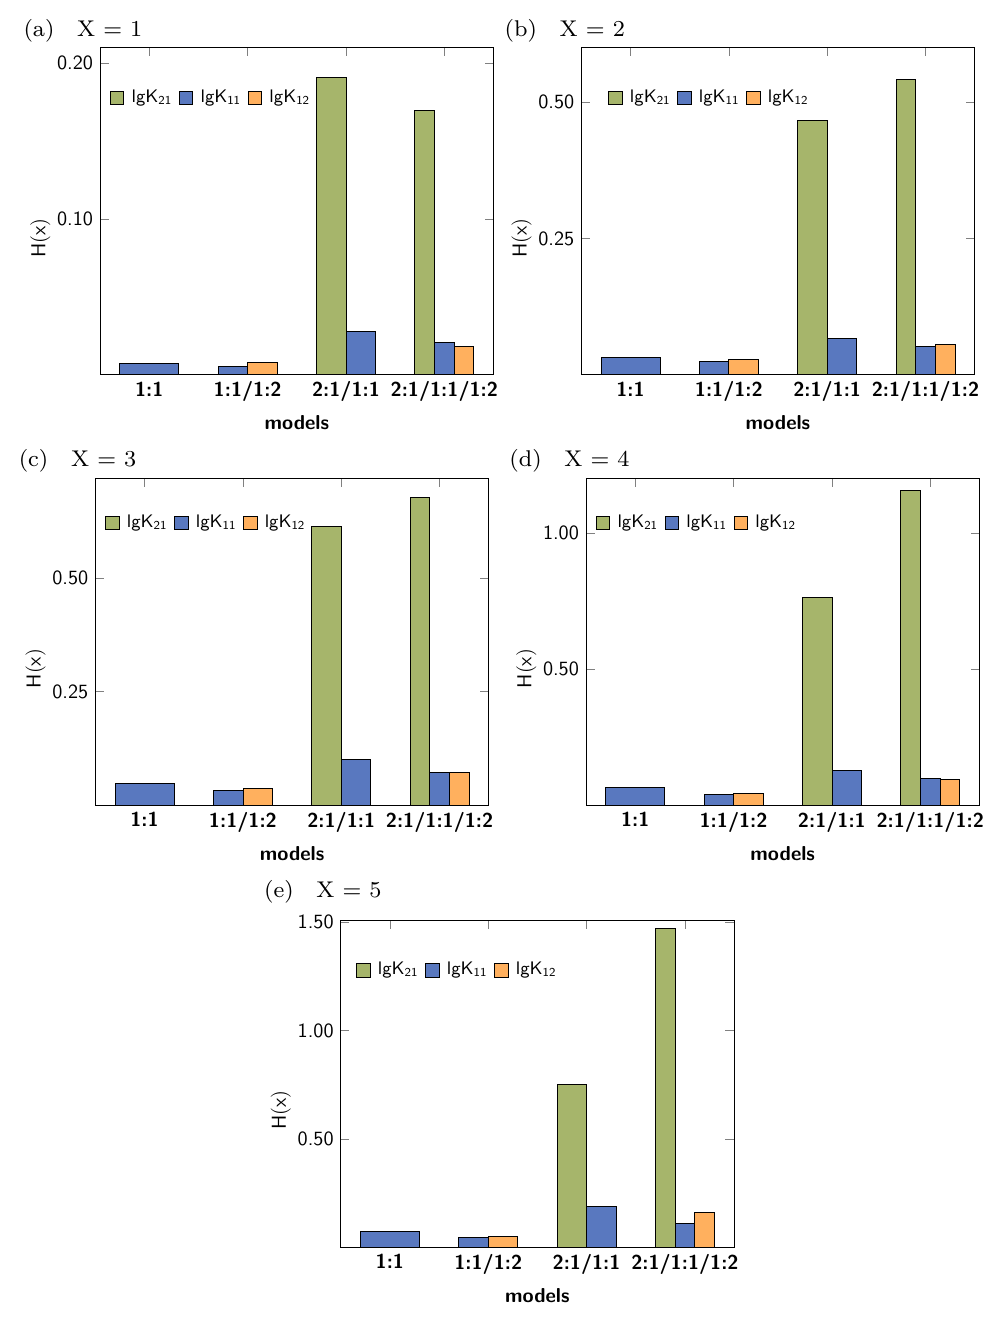
Figure 6 (A–E) Shannon entropy of the histograms obtained for the distribution of the individual sta- bility constants after several Cross Validation calculation for each